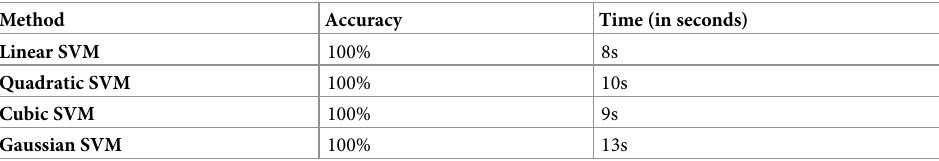
Table 2. Percentage error of alternative SVM